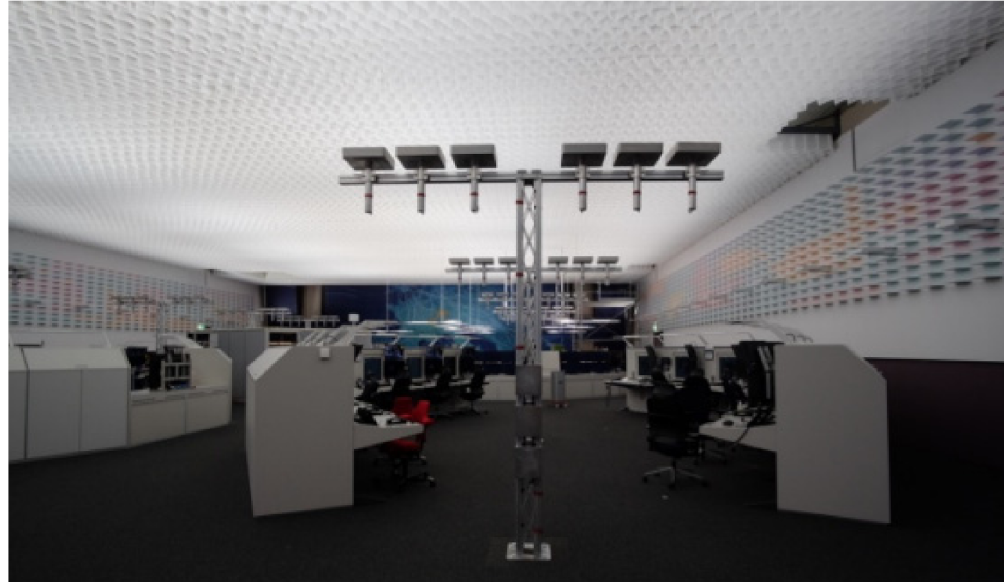
Figure 1. Light scenario during the day when workload is high.